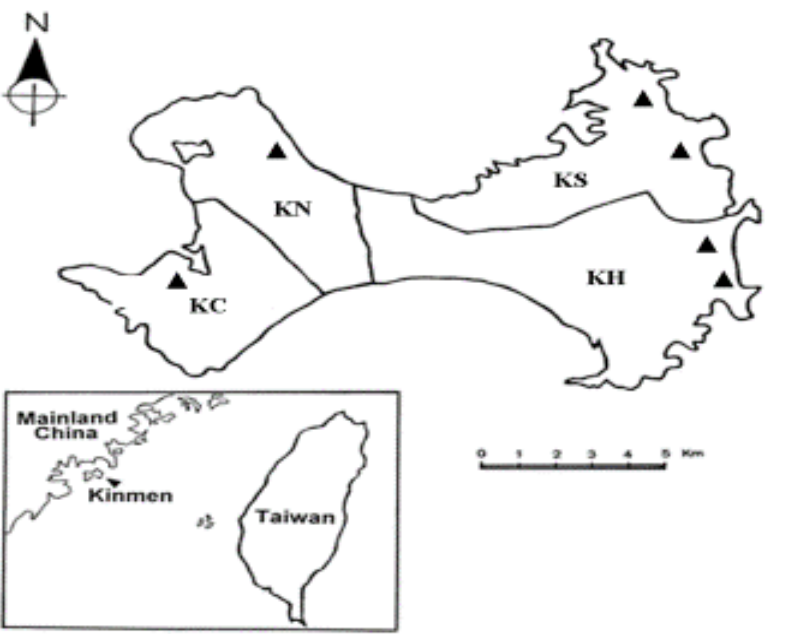
Figure 1. Map of Kinmen Island showing the various collection sites (indicated as ▲ ) for ticks removed from trapped rodents.